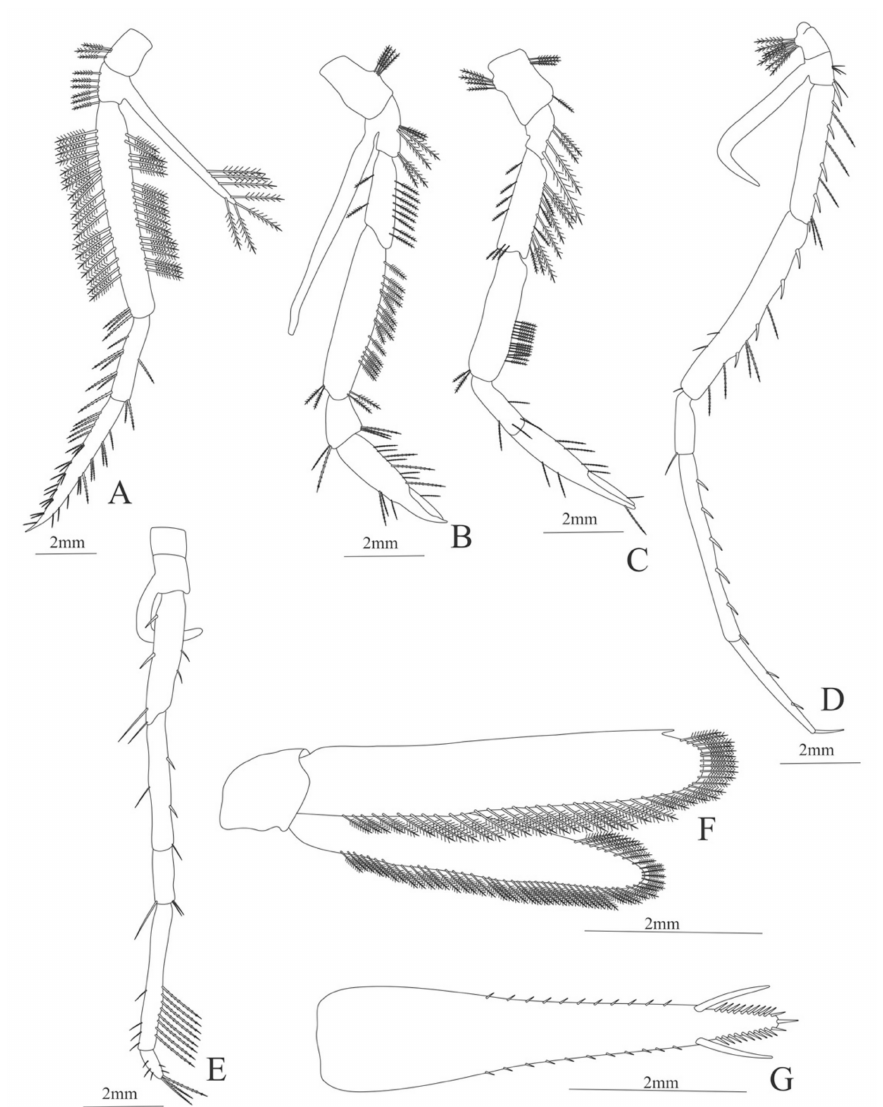
Figure 18. Systellaspis braueri : ( A ) third maxilliped; ( B ) first pereopod; ( C ) second pereopod; ( D ) fourth pereopod; ( E ) fifth pereopod; ( F ) telson; ( G )